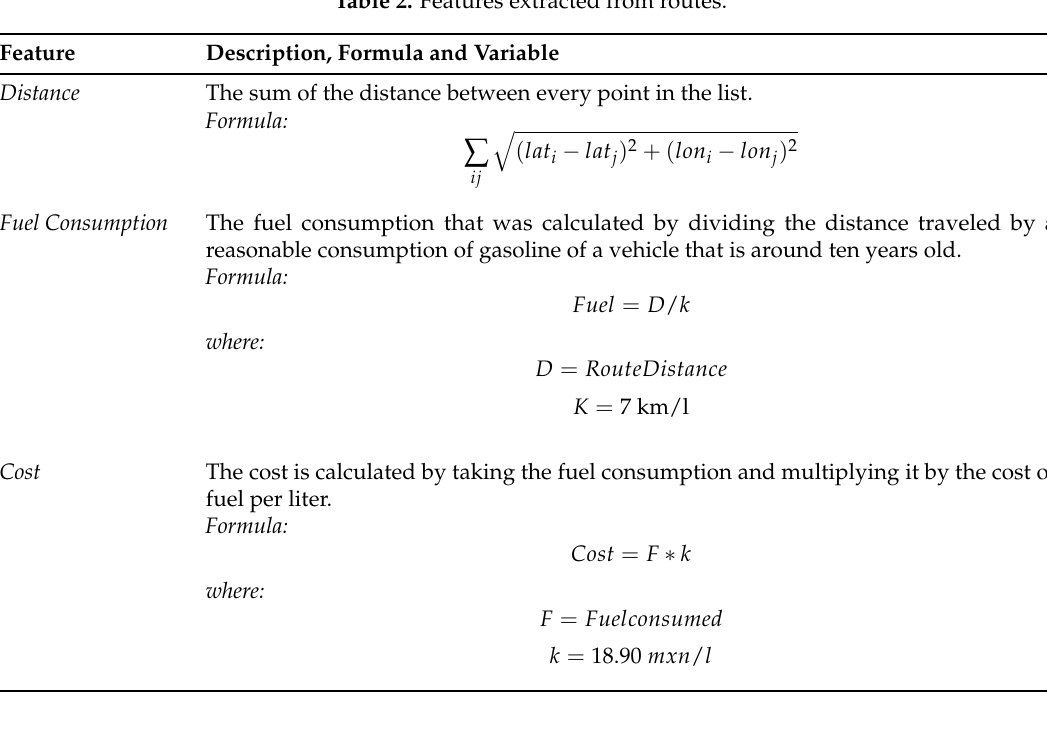
Table 2. Features extracted from